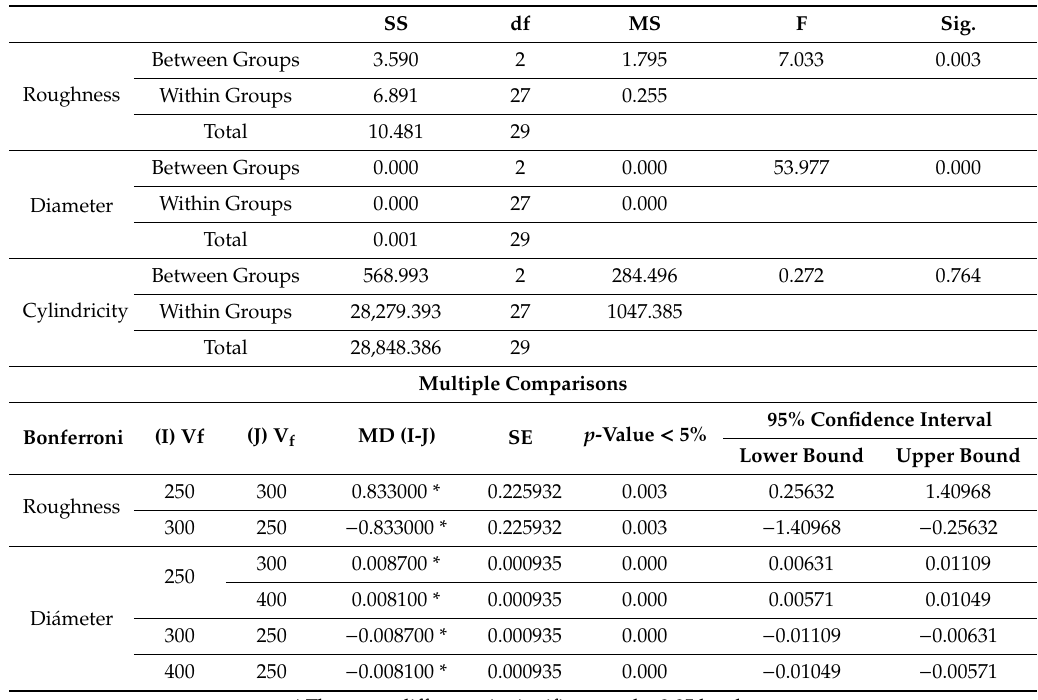
Table 8. Results of analysis of variance for v c = 105 m /